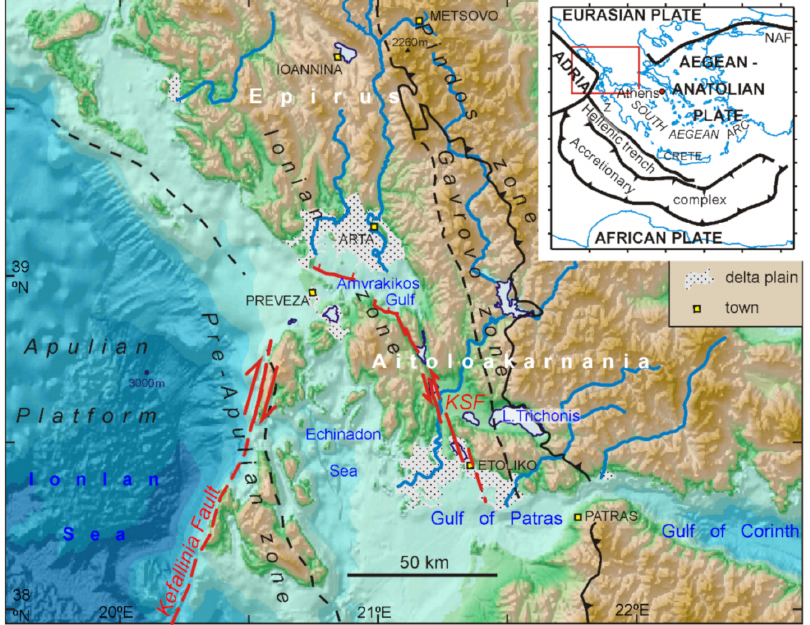
Figure 1. General geological setting of the study area. Base map from [11], rivers from [12]; isopic zones from [13]. KSF = Katouna-Stamna Faurl. Inset map shows plate tectonic setting, NAF = North Anatolian Fault; Z =